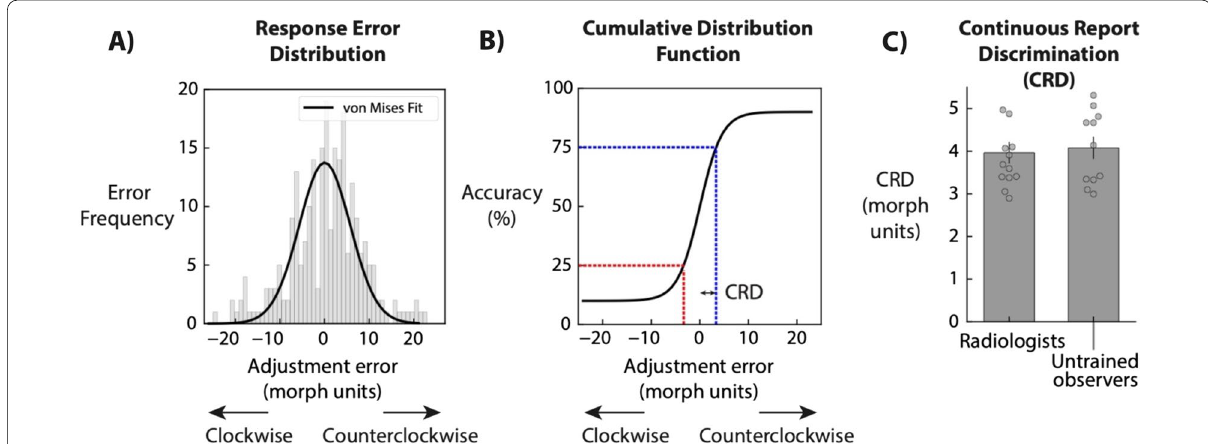
Fig. 2 Continuous Report Discrimination index (C.R.D). A For each observer, we plotted a frequency histogram of the adjustment errors and fitted a Von Mises to quantify adjustment performance. B We then converted the von Mises fit into a Cumulative Distribution Function. Continuous Report Discrimination index was calculated by taking the half difference between 25 and 75th percentile in terms of adjustment error morph units. C Each dot shows CRD index for individual observers in the two groups. Bars indicate average in Experiment 1 and 2, and error bars indicate standard error